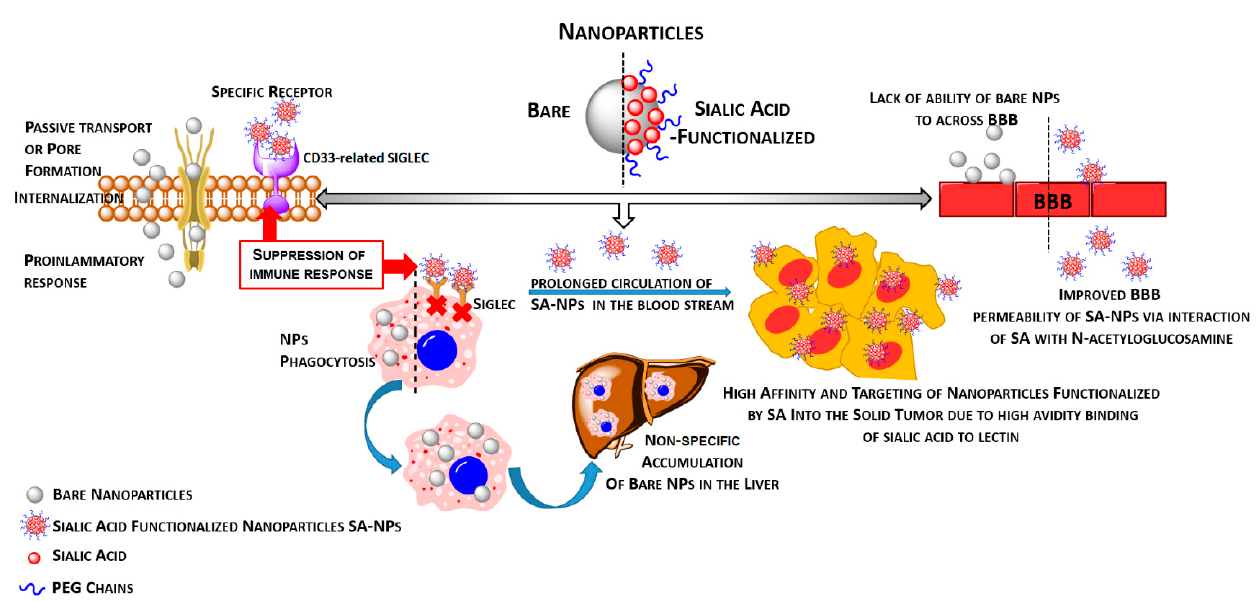
Figure 1. Modulation of the biological functions of nanoparticles after functionalization by sialic acid (SA). The SA-dependent chemical and physical features of NPs promote their activity in the field of immune response, BBB permeability, uptake and neutralization by phagocytes, and delivery to target malignant tissue.